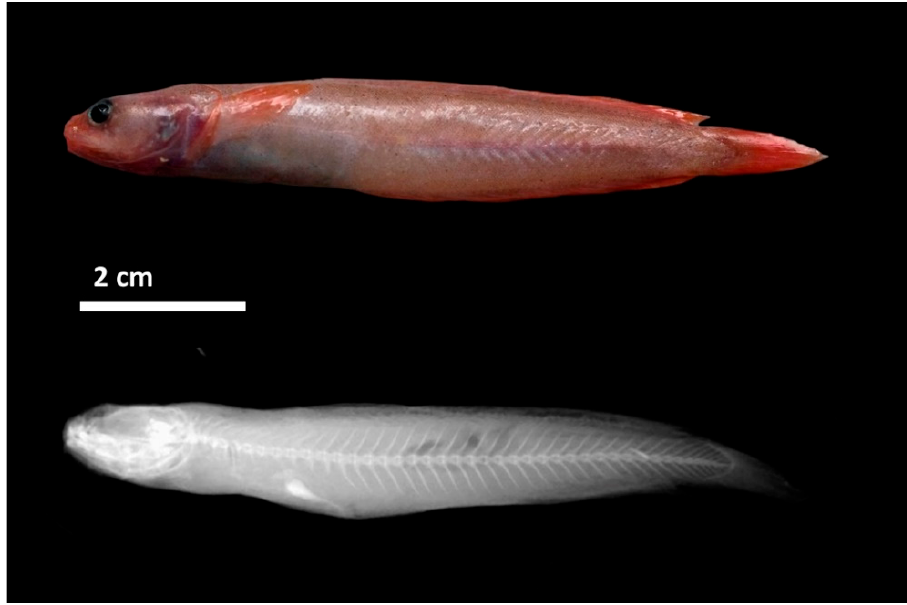
Figure 3. Gaidropsarus gallaeciae sp. nov., paratype (MHNUSC 10126-2) 76.4 mm SL ( top ), X-ray of entire body ( down ).